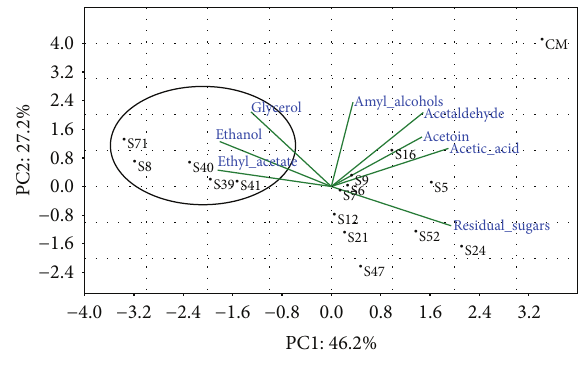
Figure 3: Principal component analysis (PCA) performed employ- ing as variables the data obtained by the chemical analysis of must fermented with the selected strains. The projection on the plan of the different variables is indicated in the plot by